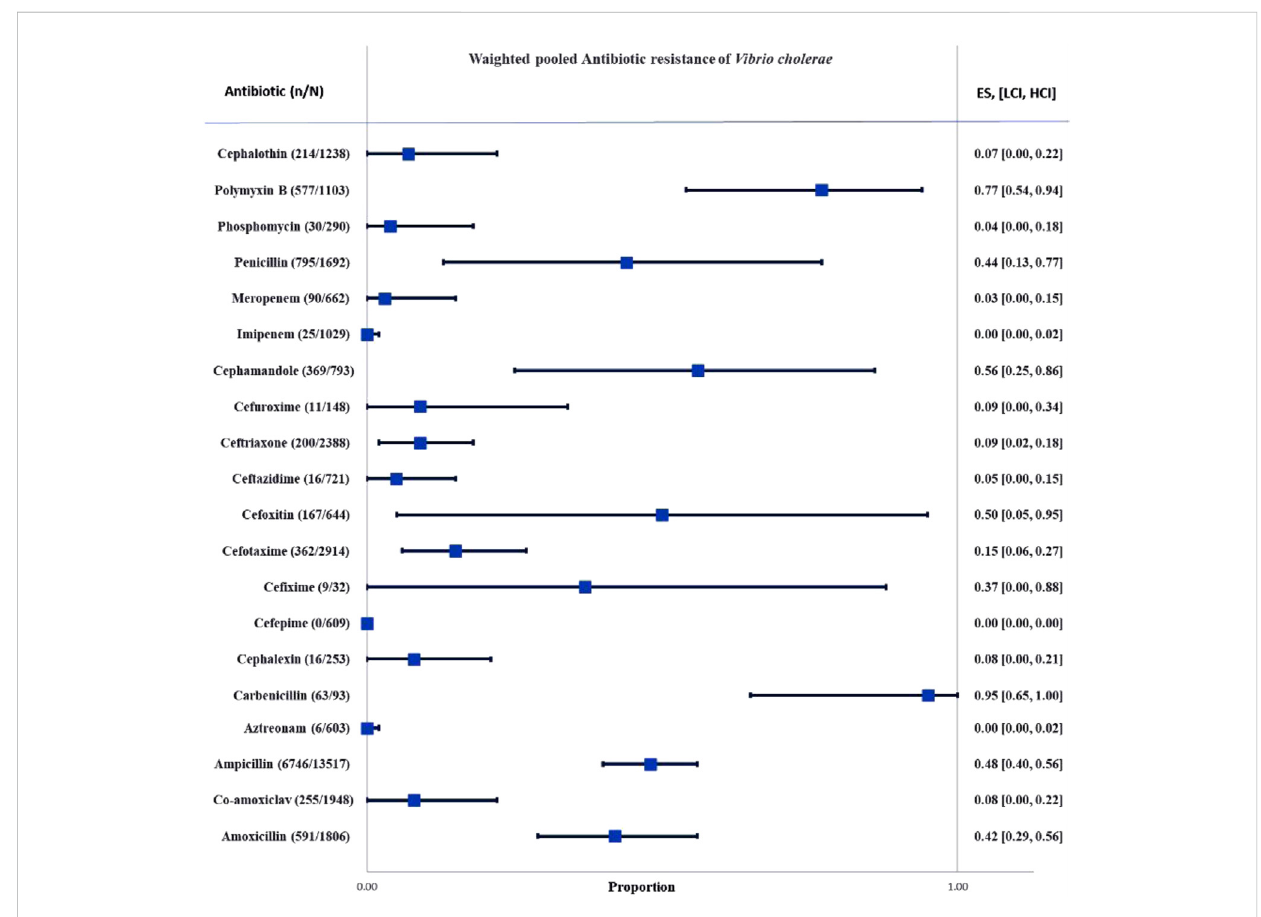
Forest plot of the weighted pooled proportion of antimicrobial-resistant Vibrio cholera . Abbreviations; Effect size or proportion of resistance (ES), number of resistant isolates (n), number of isolates (N), high con fi dence interval (HCI), low con fi dence interval